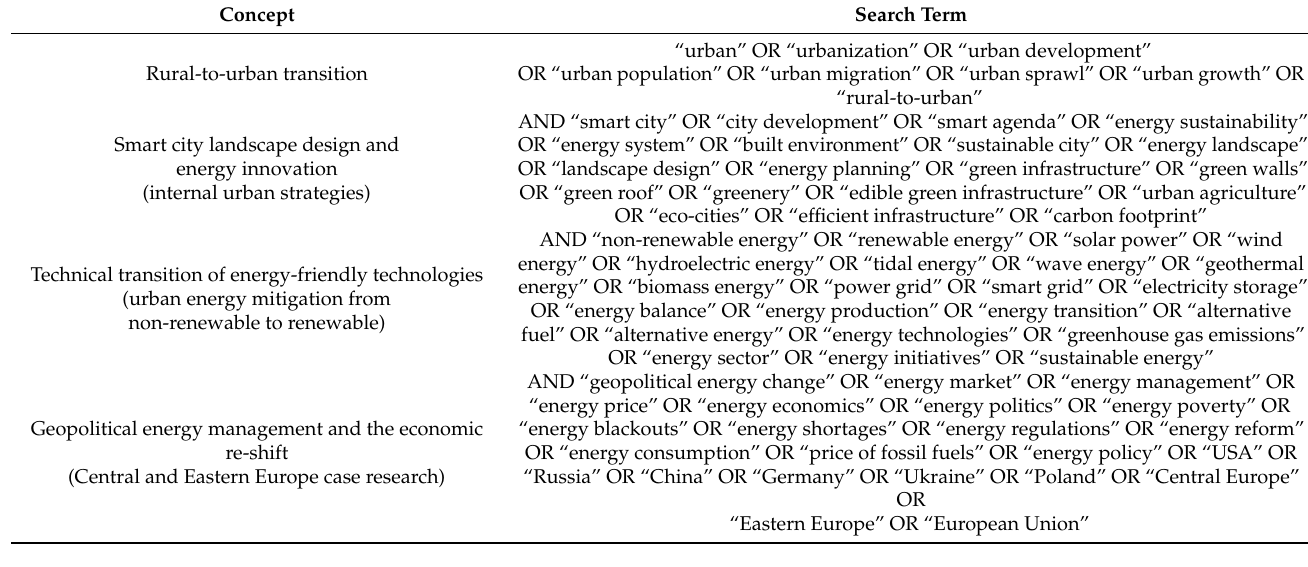
Table A1. Synthesized terms and combinative keyword search used for the methodology.